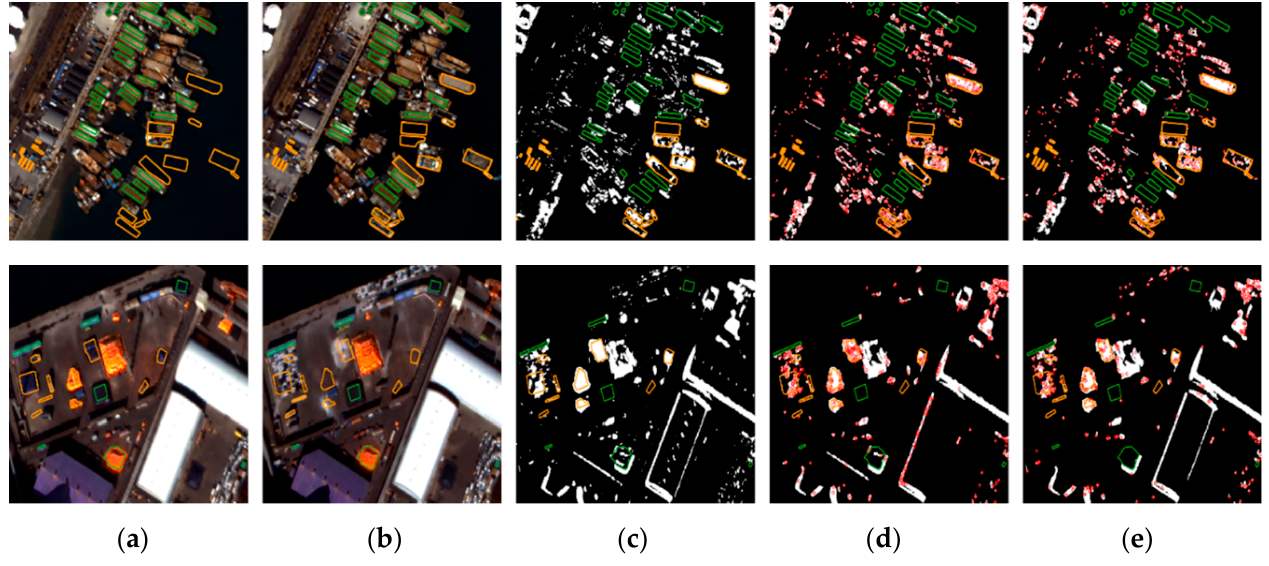
Figure 8. Comparison of pixel-based and feature point-based change detection results for Incheon: ( a ) before images, ( b ) after images, ( c ) pixel-based results, and feature-based results using ( d ) SIFT, and ( e ) AKAZE.